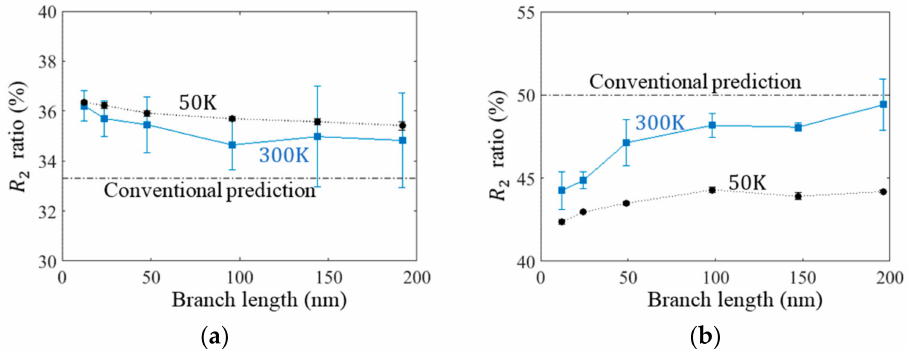
Figure 8. Effect of the temperature on heat flow in branched CNTs with ( a ) cross-junction 1 and ( b ) T-junction